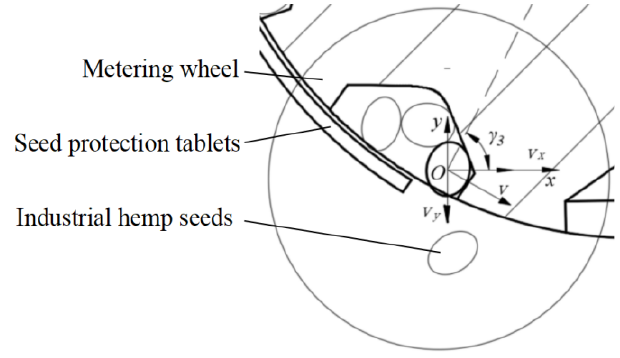
Figure 8. Analysis of seeding process.